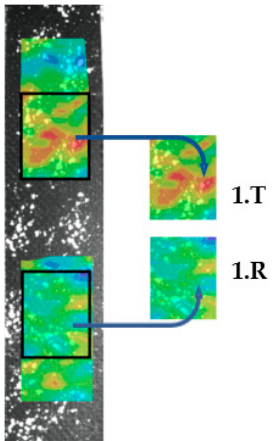
Figure 4. Interpretation of cut out surface strain fields.